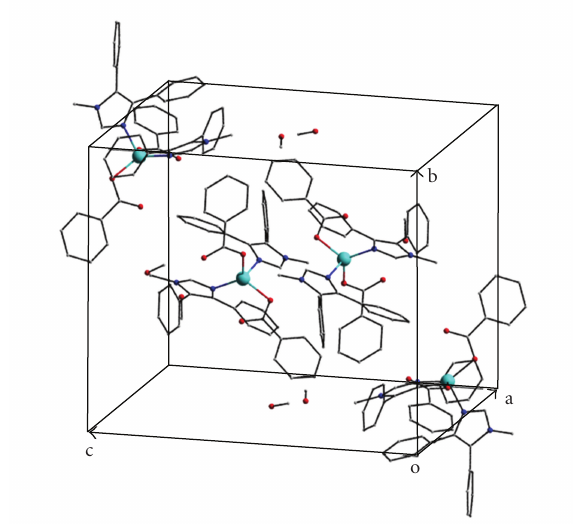
Figure 3: View of the crystal packing of complex 1 · 2MeOH. The hydrogen atoms have been omitted for clarity. Zn: turquoise; O: red; N: blue; C: